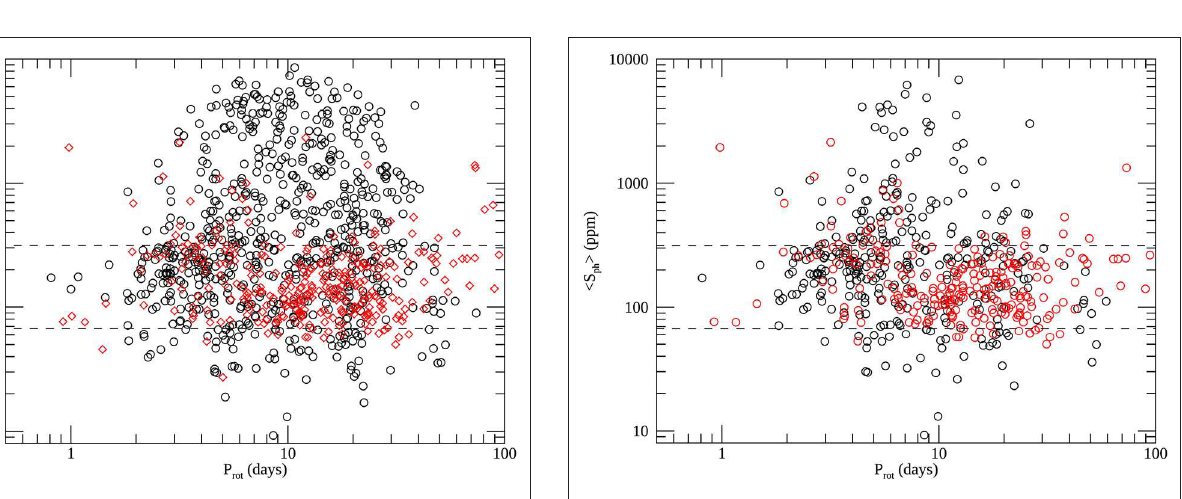
FIGURE 10 | Same as Figure 9 but for stars selected as in section